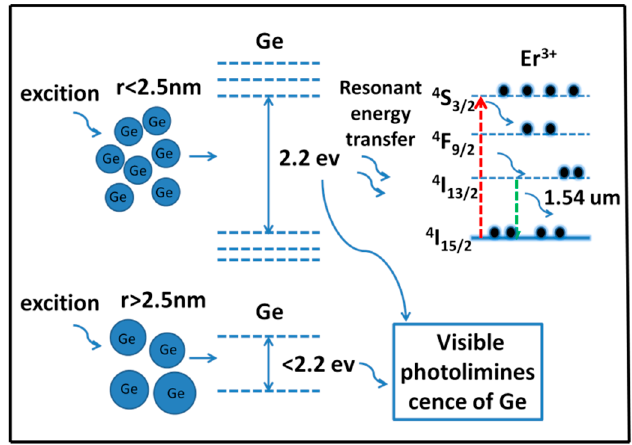
Figure 5. Schematic diagram for the proposed energy transfer process in the Ge:Er:ZnO film.